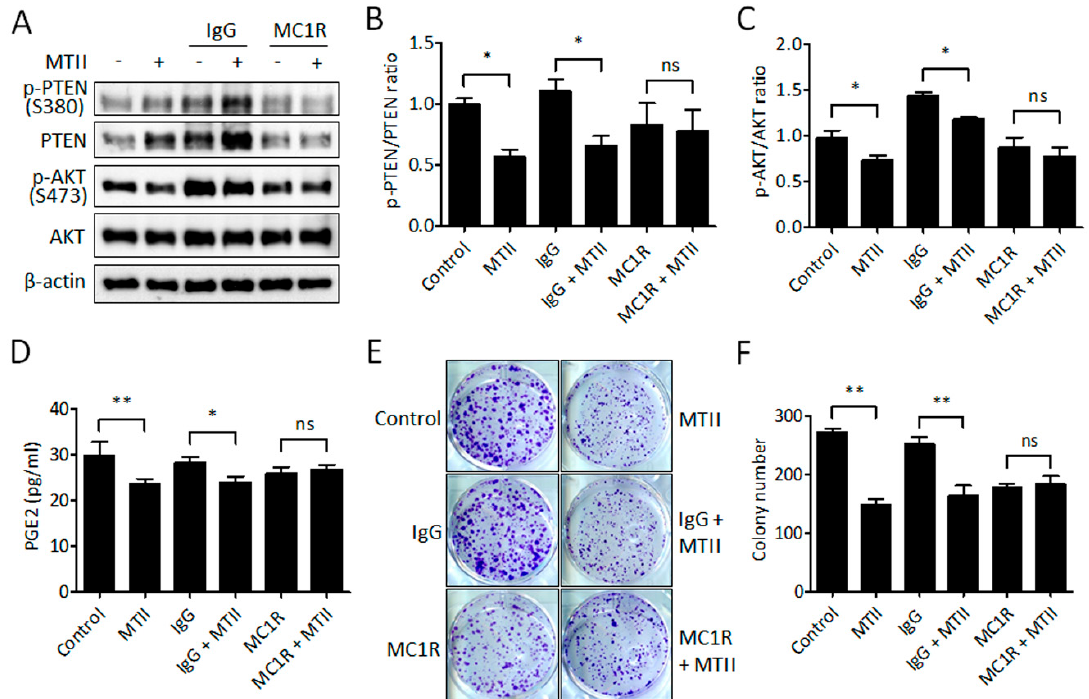
Figure 5. Effect of MC1R antibody neutralization on MTII-induced inhibition of PTEN phosphorylation and colonies formation. ( A ) Western blot analysis of PTEN and AKT expressions in cells incubation with the MTII peptide and MC1R antibody. β -actin was used for the normalized protein level. ( B , C ) The bar chart shows the protein ratio from duplicate experiments. The data are expressed as fold changes ± SD. ( D ) The levels of secreted PGE2 protein (pg/mL) were detected by ELISA assay kit from triplicate experiments. ( E ) Representative images of crystal violet staining in cells received MTII peptide and MC1R antibody challenge compared with control group. ( F ) The amounts of cell colonies were calculated from different triplication experiments and expressed as mean ± SD. *: p < 0.05, **: p < 0.01; ns, no significance